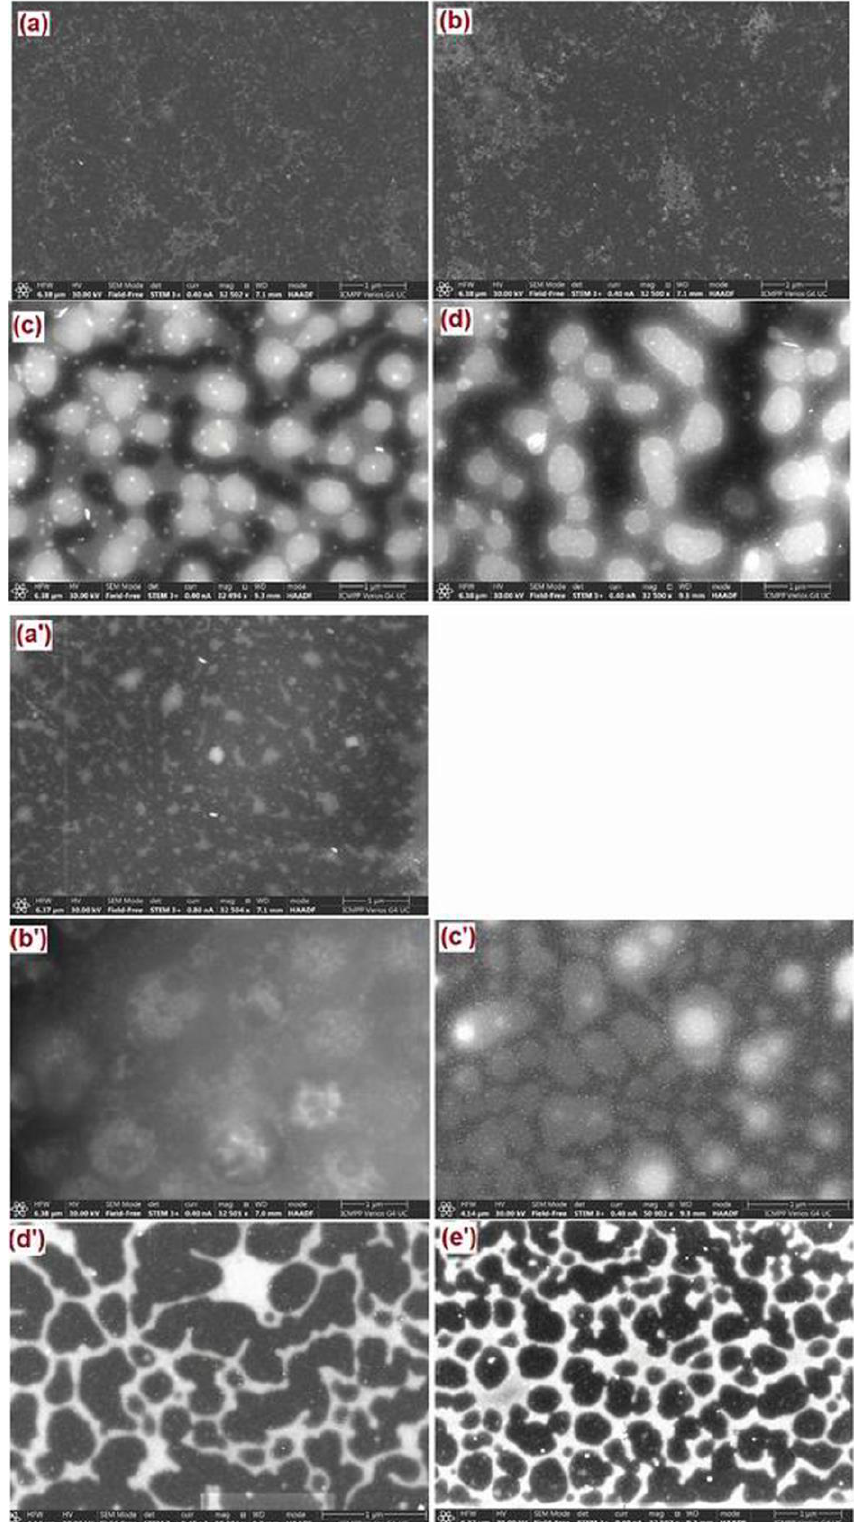
Figure 6. STEM images of the studied systems at different mixing ratios: ( a ) 3 wt%, ( b ) 5 wt%, ( c ) 10 wt% and ( d ) 15 wt% for PSFQ/Cyphos IL 101 system, and ( a’ ) 3 wt%, ( b’ ) 5 wt%, ( c’ ) 10 wt%, ( d’ ) 15 wt% and ( e’ ) 20 wt% for PSFQ/Aliquat 336 system, recorded for 1 μm scan area and magnification of 32,500×.